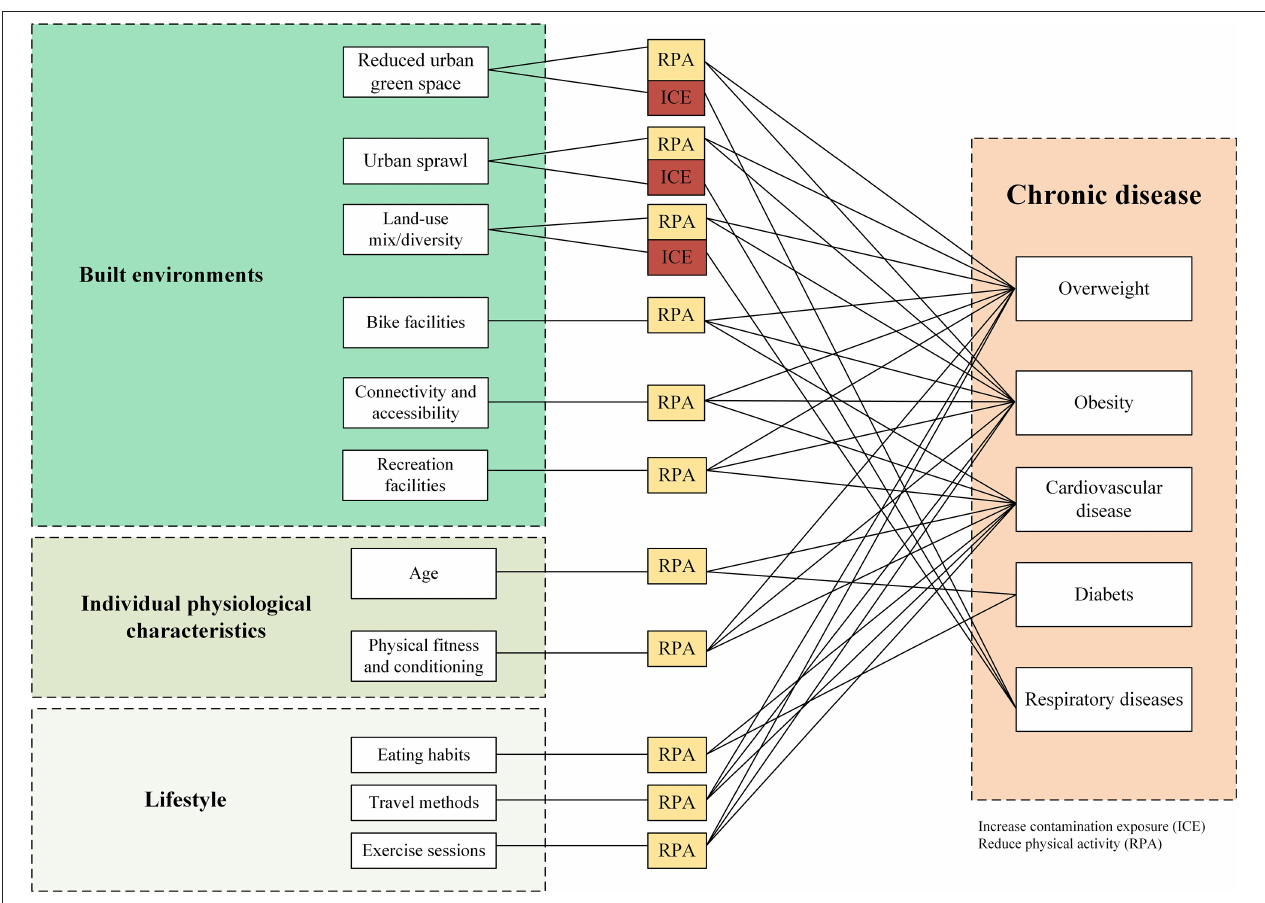
FIGURE 1 | A variety of factors would influence chronic disease through exposure and physical